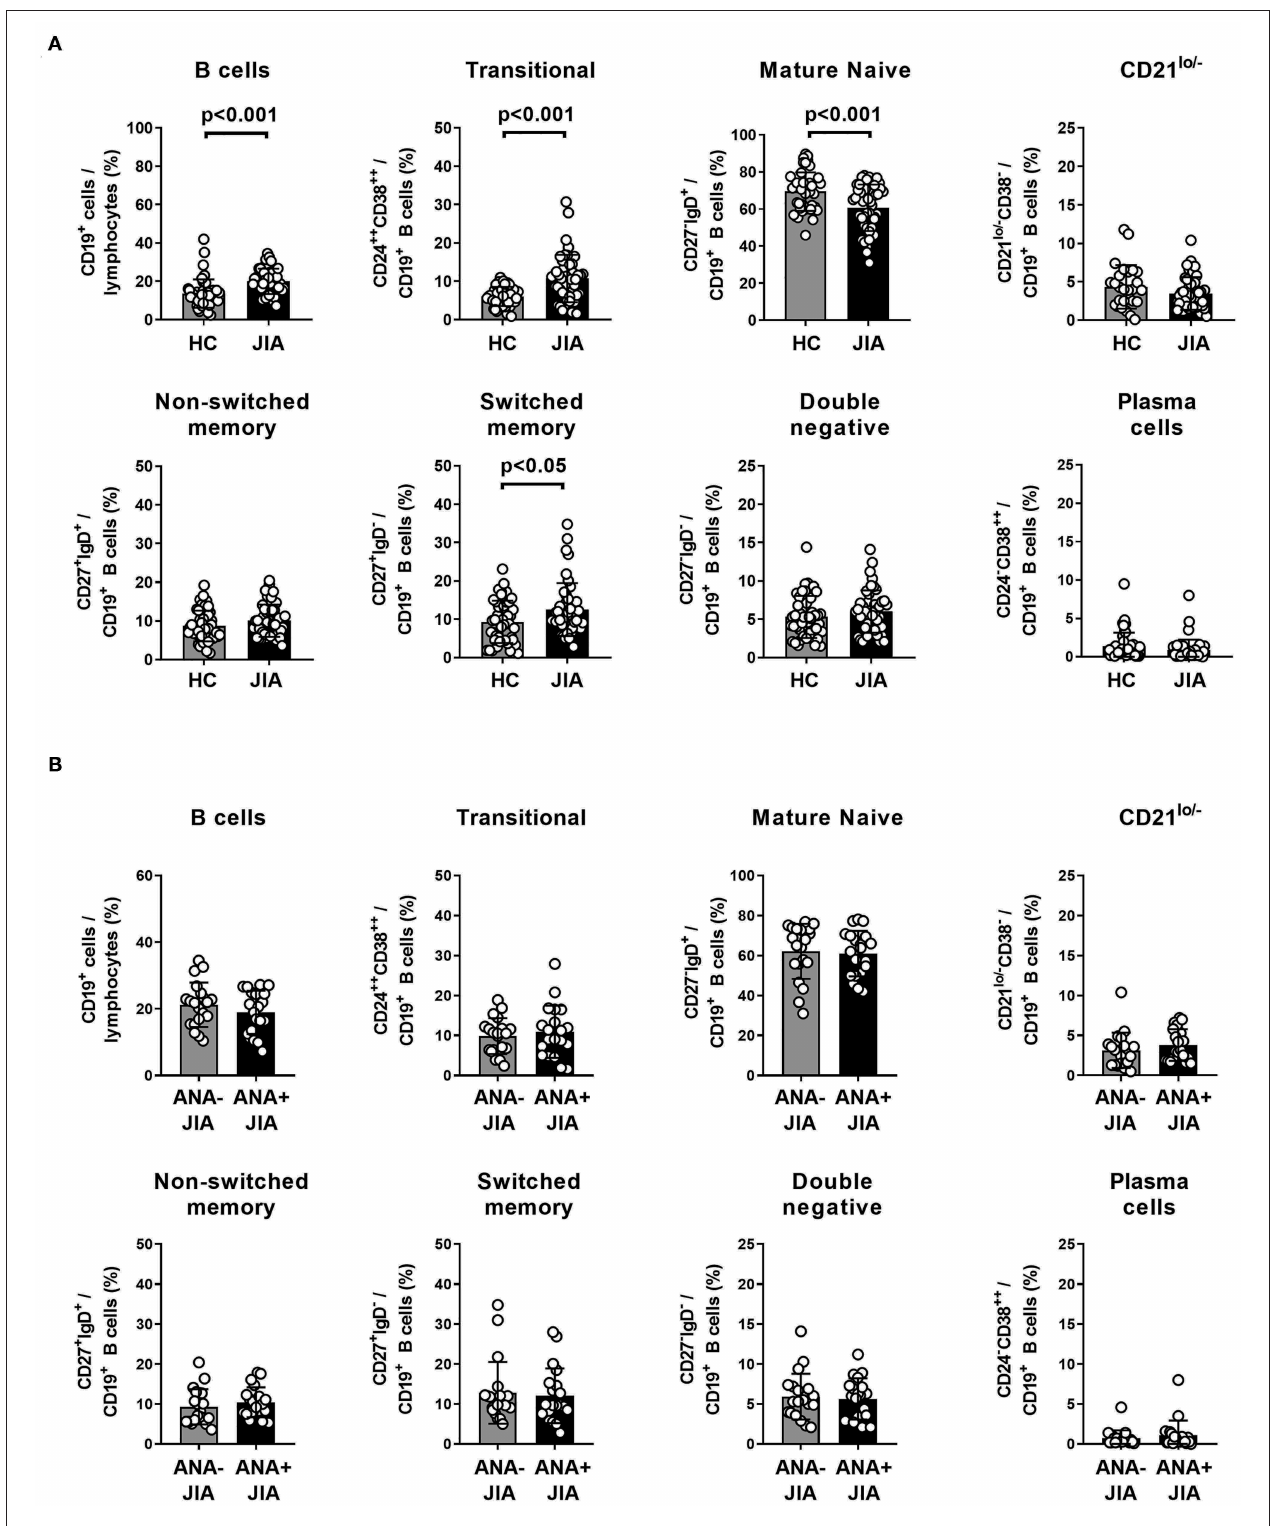
FIGURE 1 | Distribution of peripheral blood B cell population in ANA-positive and ANA-negative JIA patients. (A) Frequency of peripheral blood CD19 + B cells within lymphocytes as well as different B cell populations within CD19 + B cells in a cohort of JIA patients ( n = 45) and same number of age- and sex-matched healthy control (HC) individuals. Bars represent mean frequency with standard deviation and circles individual data points. (B) Frequency of these B cell populations from JIA patients was compared between ANA + and ANA– patients. Groups were compared using unpaired Student’s t -test.